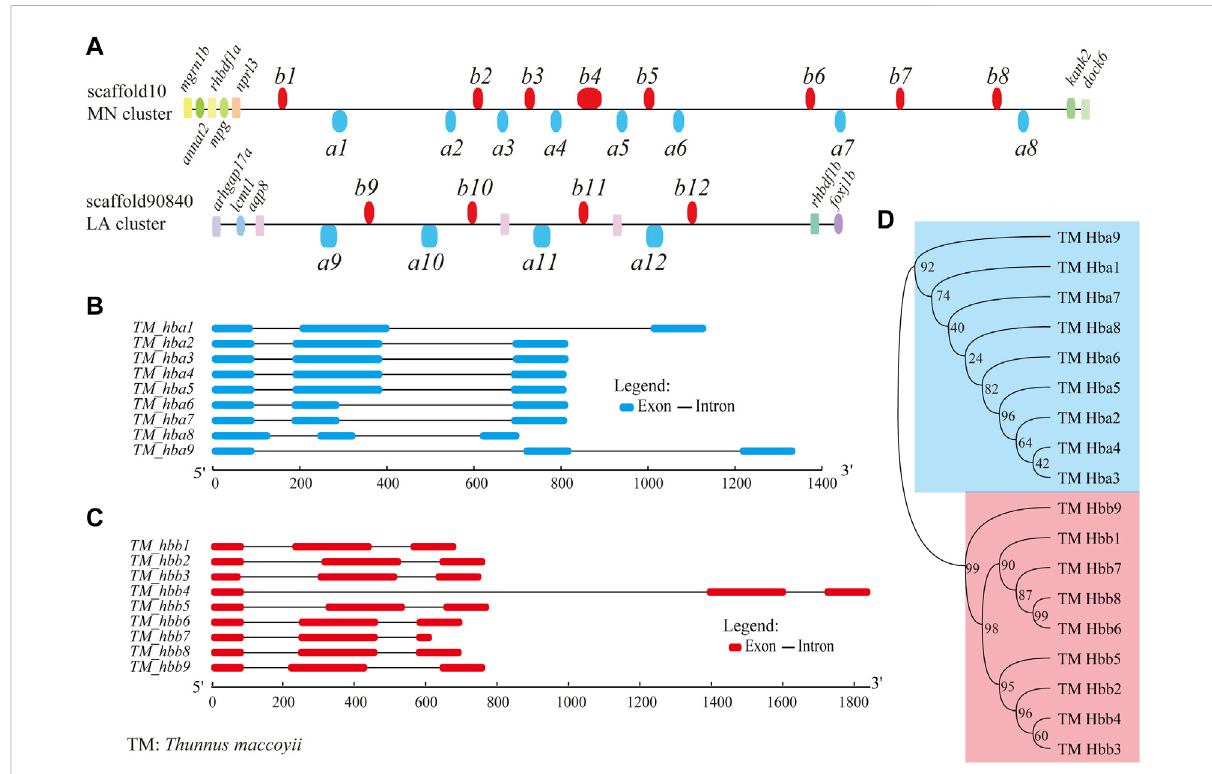
FIGURE 2 Hemoglobin genes intheSouthernblue fi ntuna genome. (A) Genome-wide distribution of hb genes in Southern blue fi ntuna ( T.maccoyii , TM). hb genes above the line are encoded by forward strands, while those below the line were encoded by reverse strands. We added the aqp8-hba-hbb repeats with six more hb s (between a10 and b12 ) in the LA cluster, since they are present in the public NCBI version. (B,C) Detailed structures of hb genes (classi fi ed into hba and hbb ; marked in blue and red, respectively). (D) Phylogenetic evolution of hb